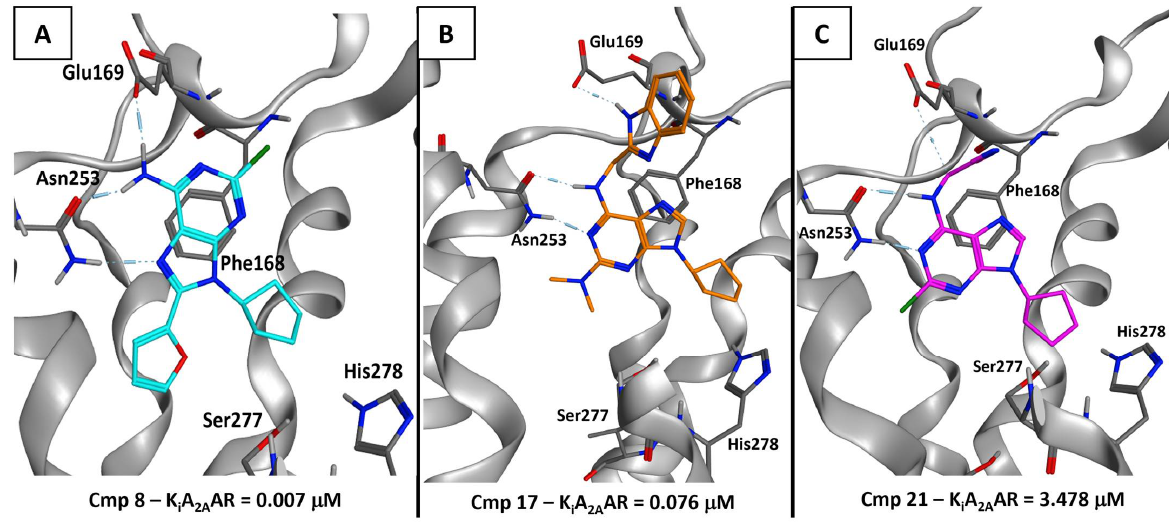
Figure 6. Depiction of the three poses selected for compounds 8 (colored in cyan, panel ( A )), 17 (in orange, panel ( B )), and 21 (in purple, panel ( C )) in complex with A 2A AR. In each image, the main residues surrounding the ligands in the binding site are labeled, and the hydrogen bonds are represented with dashed lines. All of the images were created and rendered with MOE.